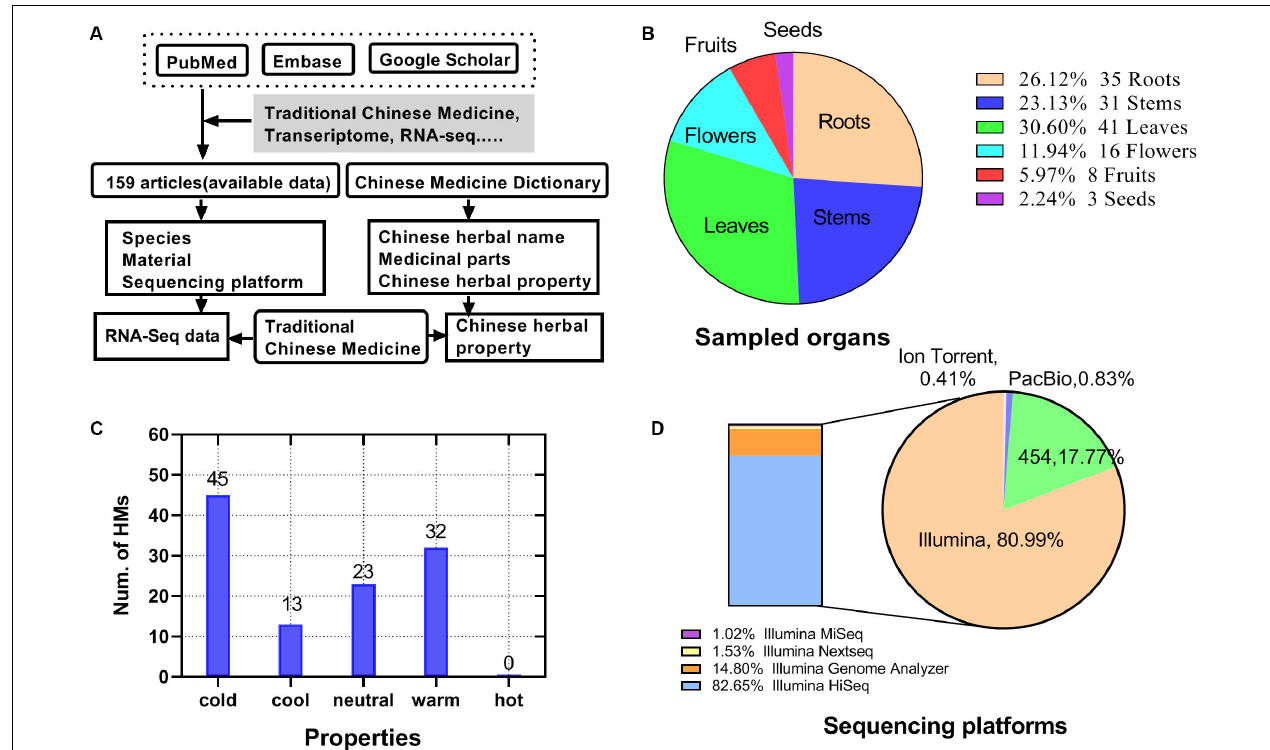
FIGURE 2 | Statistics for HMs high-throughput transcriptome literature data. (A) Source and process of data acquisition of high-throughput transcriptome and HMs’ information. (B) Distribution of sampled organ of HMs. (C) Quantity of HMs for each property. (D) Distribution of types of sequencing